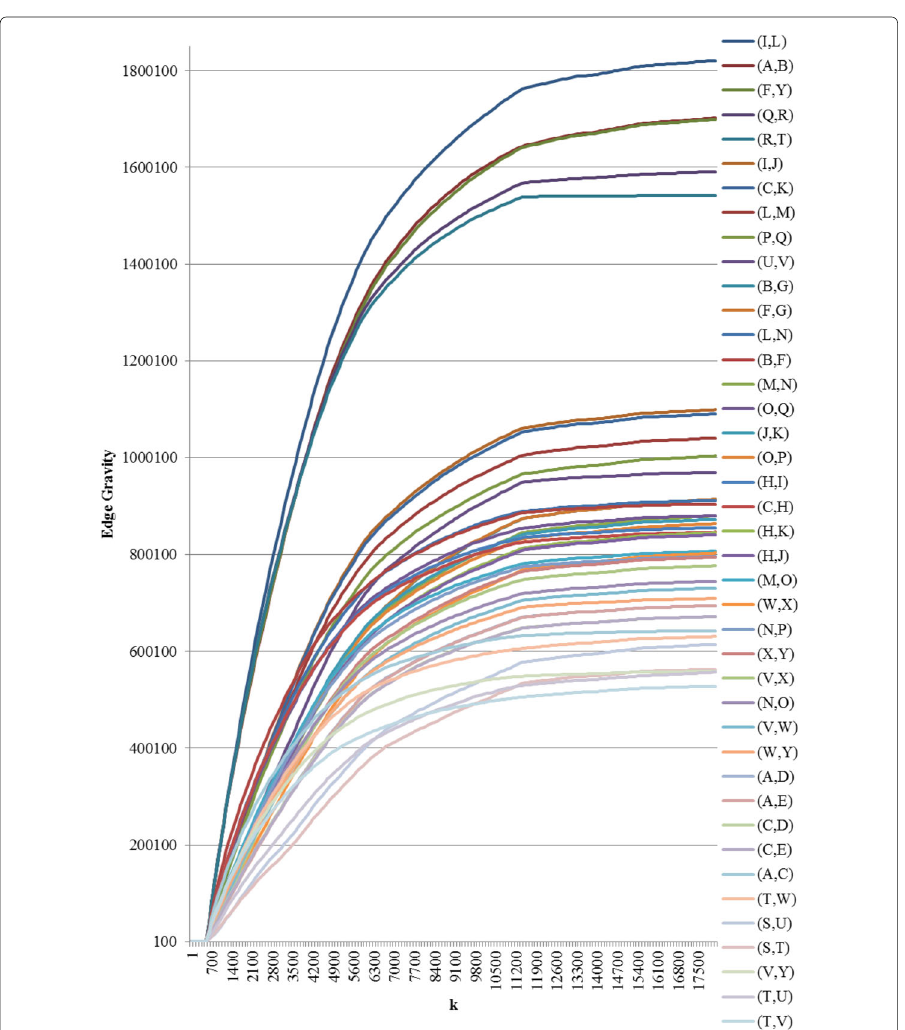
Fig. 12 Edge Gravity solutions for Granovetter’s Example B when solving KSP for k = 1,100,200,300, ... ,17400,17500